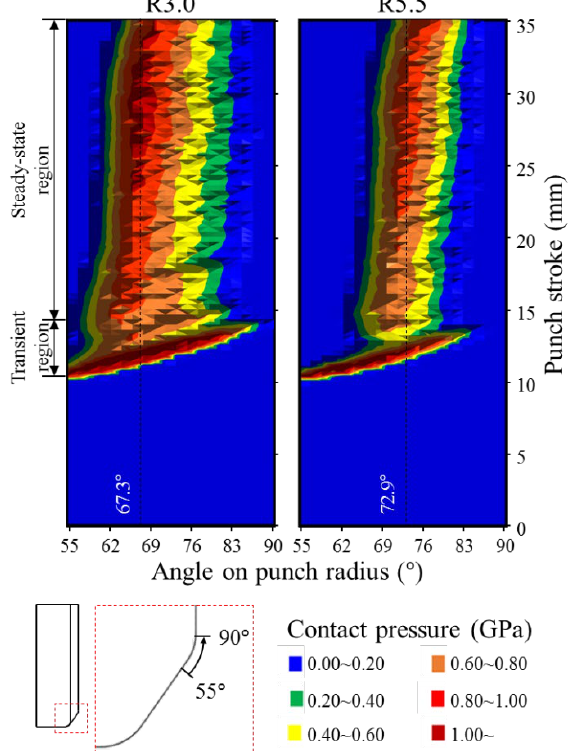
Figure 7. Time-dependent evolution of contact pressure on the punch surface during the stamping process.